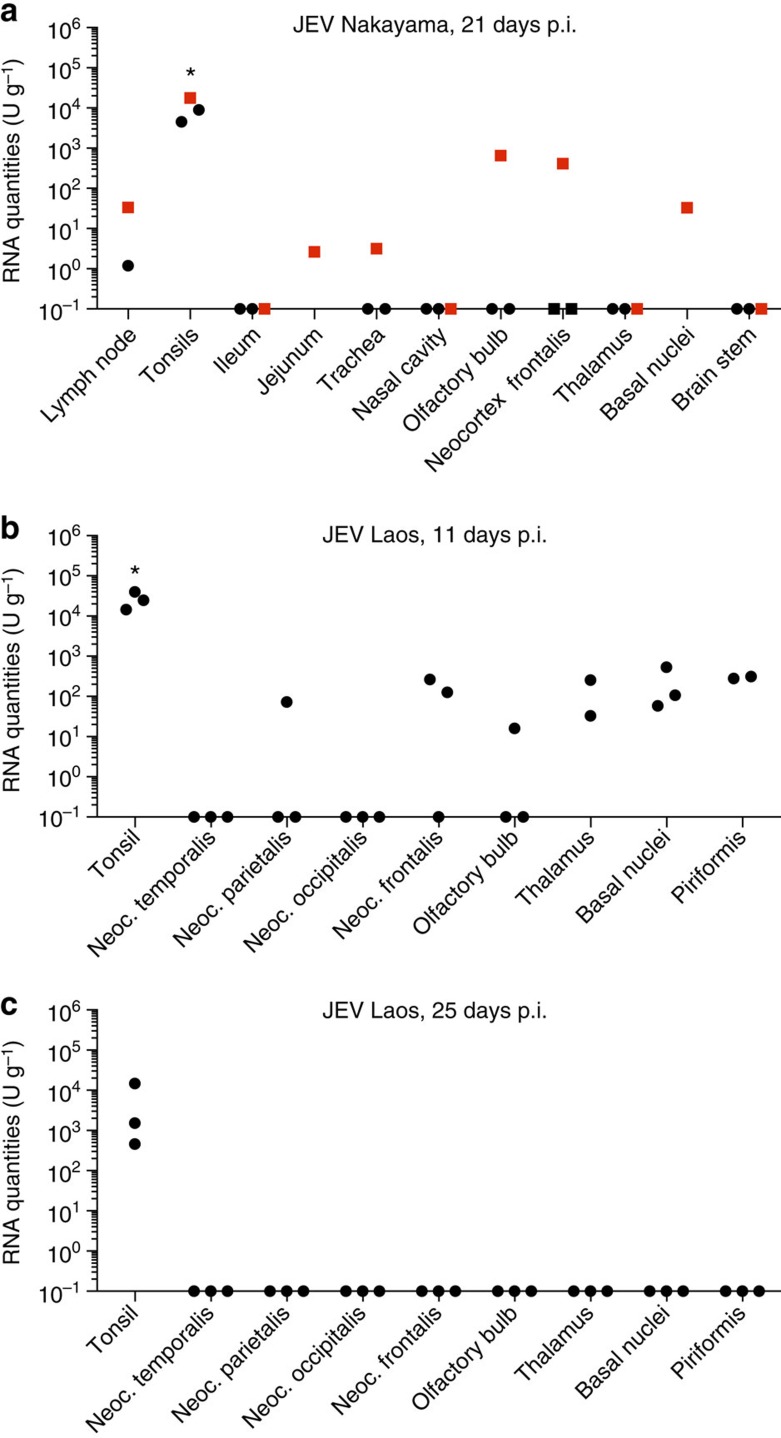
Persistence of JEV in the tonsils.(a) Various tissues were collected from oronasally infected pigs (107 TCID50, Nakayama strain) and analysed for viral RNA load by real-time RT–PCR. The animal depicted by red squares is identical to the animal depicted in Fig. 4b, which became viraemic at day 17 p.i. but cleared virus from the blood by day 21 p.i. (b,c). Six pigs were needle-infected with the Laos strain of JEV, and tonsils were analysed for viral RNA load at 11 and 25 days p.i. Viral RNA loads were determined as for the other figures and expressed as U ml−1. Asterisks (*) indicate significant differences calculated with a nonparametric two-tailed Mann–Whitney U-test (P<0.05). Neoc., neocortex.